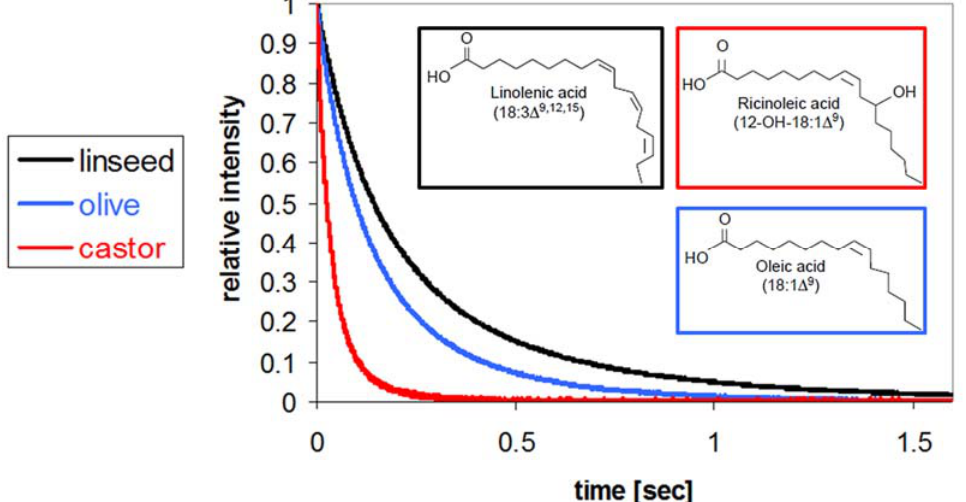
Figure 1. Effect of oils’ chemical composition and structure on low-field nuclear magnetic resonance (LF-NMR) T 2 relaxation curves. Linseed oil, olive oil, and castor oil with different profiles of unsaturated fatty acids, and therefore different structural organizations, show different rates of proton relaxation curves.